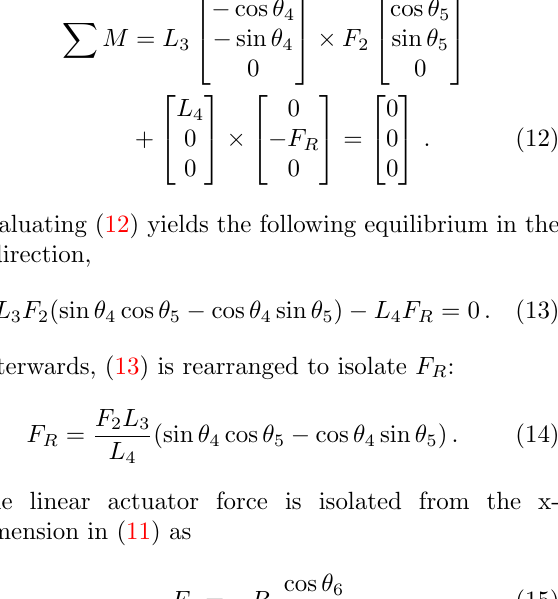
Figure 13: Complete 3D model with numbered compo- nents. The width of the test rig is 350